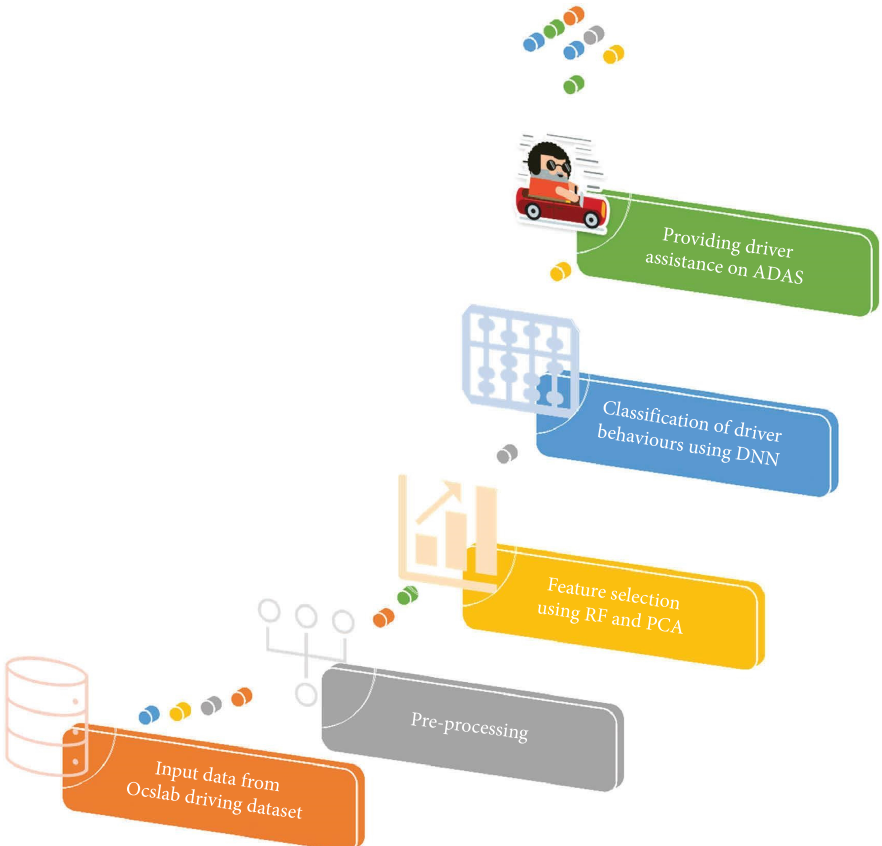
Figure 1: Block diagram of the proposed